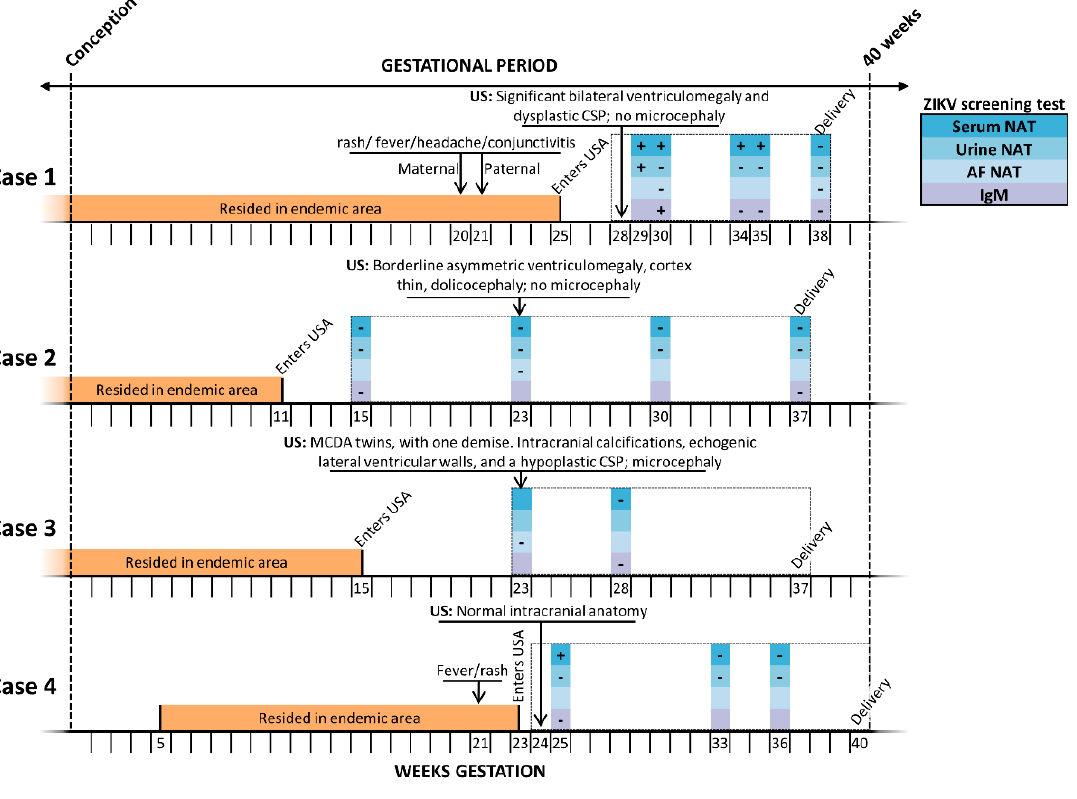
Figure 1. Timeline of subjects’ exposure risk, clinical findings, and standard clinical laboratory testing for ZIKV. The entire gestational interval during which antenatal care was delivered is outlined by a checked box, with annotated possible windows of endemic exposure (orange bar) and post-